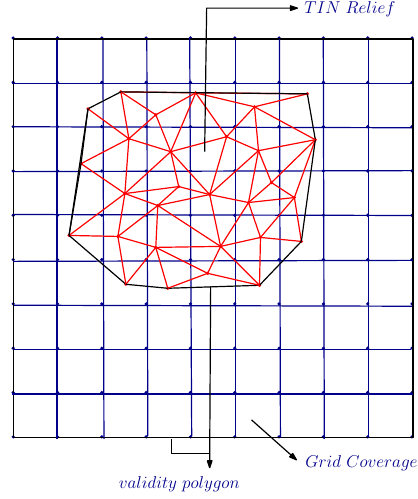
Figure 3: TIN + Grid combination in CityGML. TIN vertices